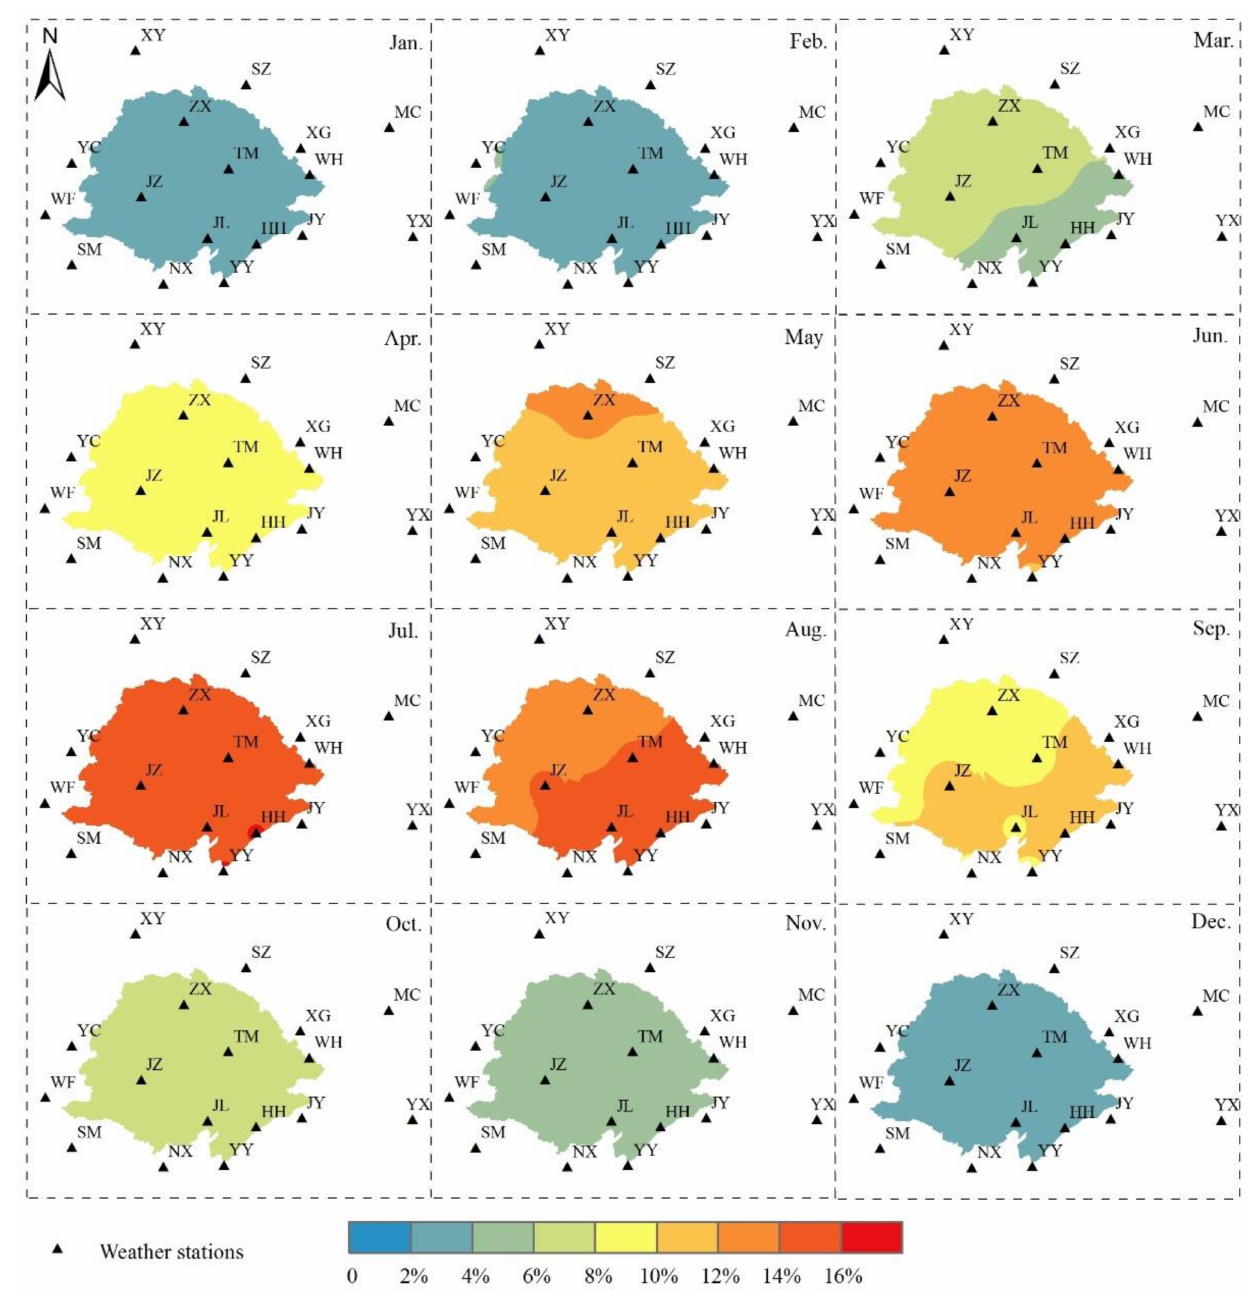
Figure A3. Spatial distributions of mean monthly ET 0 in JHP from 1977 to